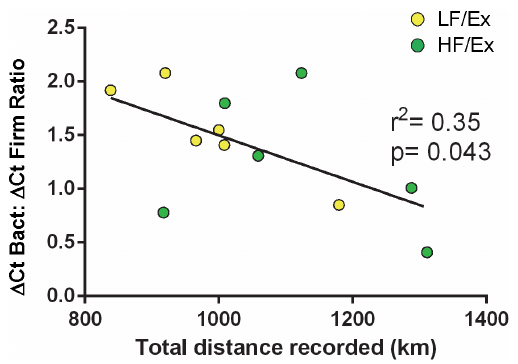
Figure 6. D Ct Bacteroidetes: D Ct Firmicutes Ratio Correlates with Exercise Distance. There was a significant, but modest inverse relationship between the D Ct Bacteroidetes: D Ct Firmicutes ratio and the distance recorded for the combined LF/Ex and HF/Ex mice. Data analyzed by Pearson product-moment correlation coefficient with an alpha level of p , 0.05. n=6 all groups.